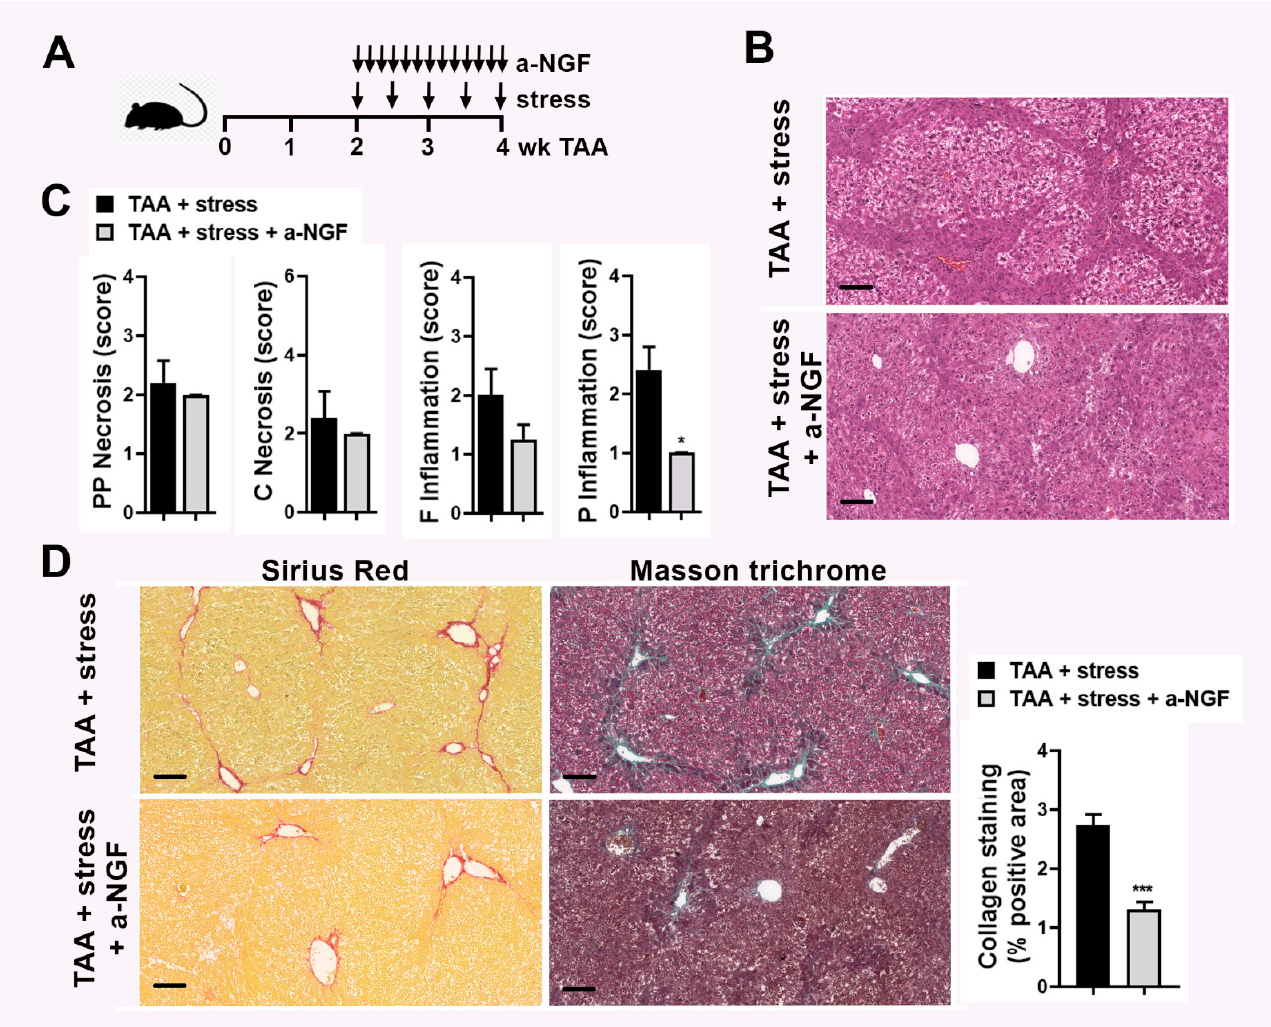
Figure 2. ( A ) Experimental murine model: Thioacetamide (TAA) was administered for 4 weeks (wk) to induce fibrosis, stress stimulus was performed by exposition to sound stress for the duration of 24 h starting on week 2 of TAA administration, twice a week, and for NGF blocking, mice were i.p. injected with neutralizing antiserum against NGF daily between week 2 and week 4. ( B ) Representative images of H&E staining on liver sections of mice with fibrosis and stress (TAA + stress) and injected with neutralizing antiserum against NGF (a-NFG). Bar = 100 µm. ( C ) Score of periportal and periseptal (PP) necrosis, confluent (C) necrosis, focal (F) inflammation, and portal (P) inflammation. Results are expressed as mean score ± S.E.M. * p < 0.05 (Kruskal–Wallis test). ( D ) Representative images of Sirius red and Masson’s trichrome staining on liver sections. Bar = 100 µm. Quantification of collagen deposits based on Sirius red-stained sections was per- formed by morphometric analysis and % positive area ± S.E.M was depicted. ** * p < 0.001 (Kruskal–Wallis test).